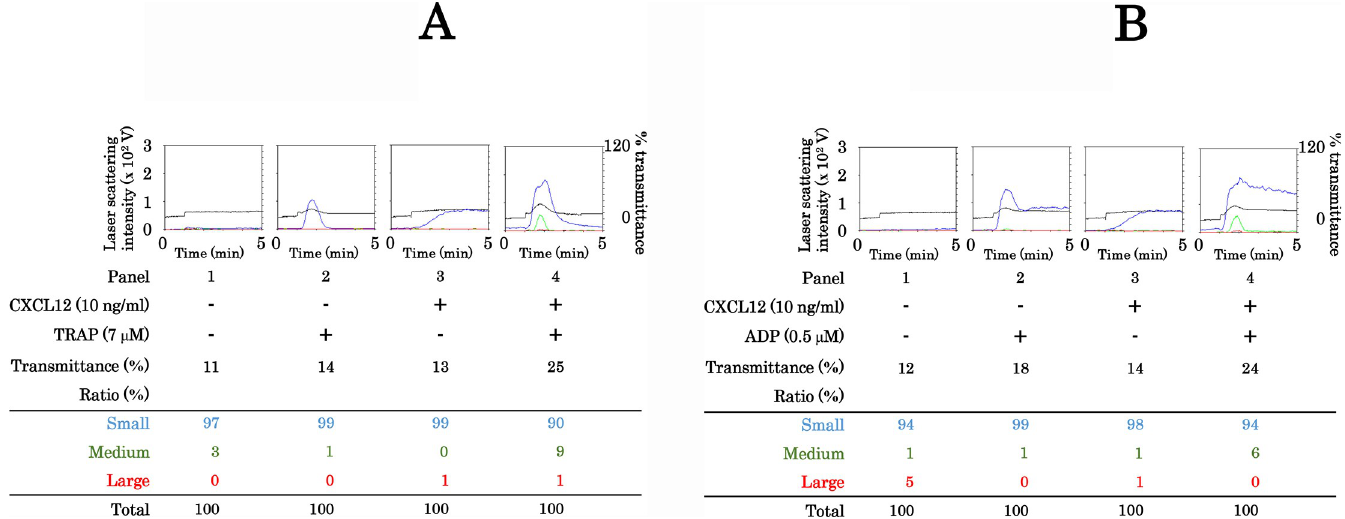
Fig 2. Effect of simultaneous stimulation with TRAP or ADP, and CXCL12 in low doses on platelet aggregation. PRP was simultaneously stimulated by 7 μ M of TRAP (A) or 0.5 μ M of ADP (B) and 10 ng/ml of CXCL12 for 5 min. The reaction was terminated by the addition of ice-cold EDTA (10 mM) solution. The black line indicates the percentage of transmittance of each sample (isolated platelets recorded as 0%, and platelet-poor plasma recorded as 100%). The blue line indicates small aggregates (9–25 μ m); green line, medium aggregates (25–50 μ m); red line, large aggregates (50–70 μ m). The lower panel presents the distribution (%) of aggregated particle size as measured by laser-scattering. The representative results are